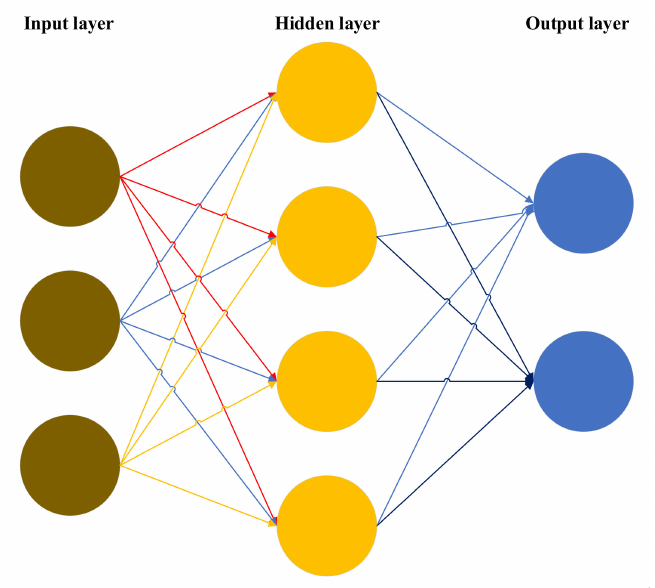
Figure 3. MLP algorithm flow